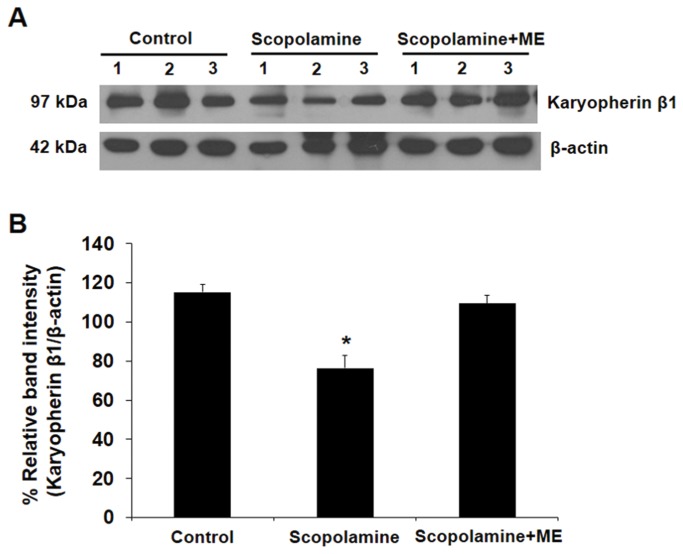
Western blot analysis of karyopherin β1 (KPNB1) in mouse brain homogenates.Scopolamine-treated mice with or without prior ME treatment were obtained from passive avoidance test. At the end of the test, whole brain from the mice was subjected to protein extraction. A total 30 µg proteins derived from brain extracts (n=3) were resolved by 12% SDS-PAGE and transferred onto a nitrocellulose membrane. After blocking non-specific bindings, the membrane was incubated with mouse monoclonal anti-KPNB1 (1:1,000 in 1% skim milk/PBS) and then incubated with rabbit anti-mouse IgG conjugated with horseradish peroxidase (1:2,000 in 1% skim milk/PBS). β-actin served as the loading control. The immunoreactive bands were visualized by chemiluminescence and autoradiography. Data was presented as KPNB1 band intensity relative to β-actin band. KPNB1 (97 kDa) level was significantly decreased after treatment with scopolamine but could be successfully preserved at its basal level by mangosteen extract. Data were reported as Mean ± SEM (n=3). * P < 0.05 compared to the control.